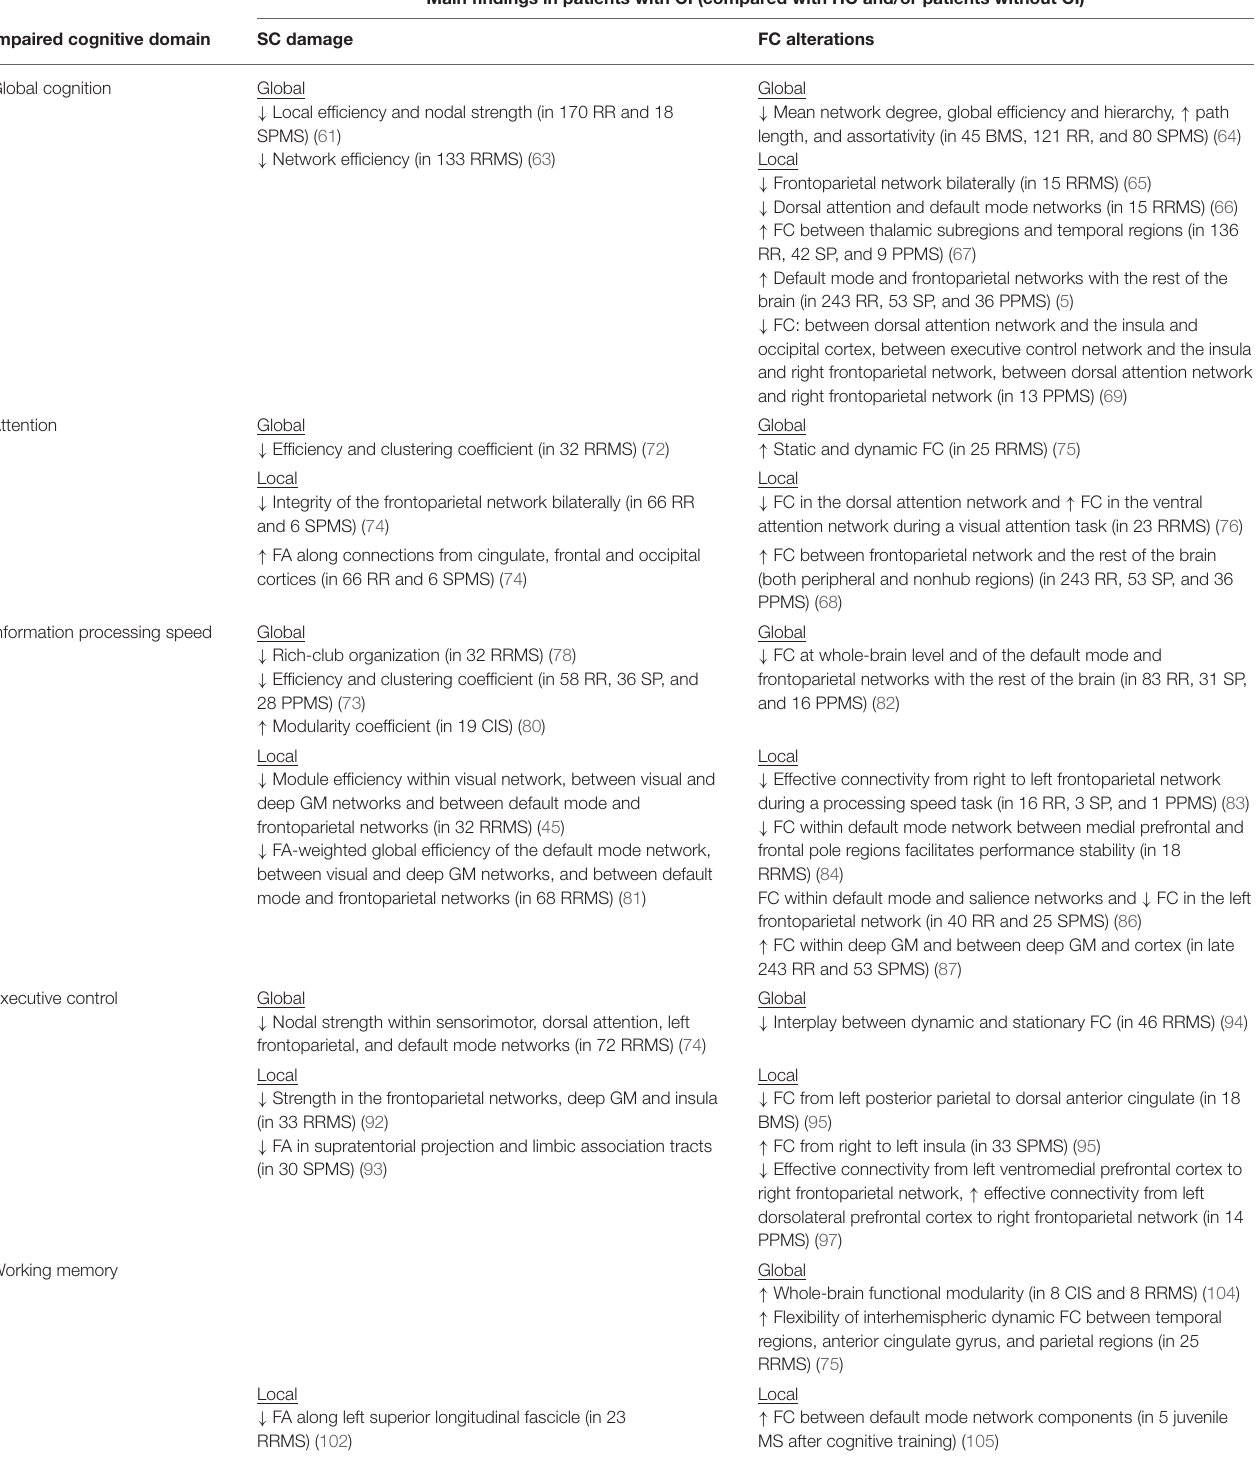
TABLE 1 | Summary of the main findings from MRI studies in MS patients showing, for each impaired cognitive domain, structural connectivity (SC) damage and functional connectivity (FC) alterations at both global and local levels (when present). Main findings in patients with CI (compared with HC and/or patients without